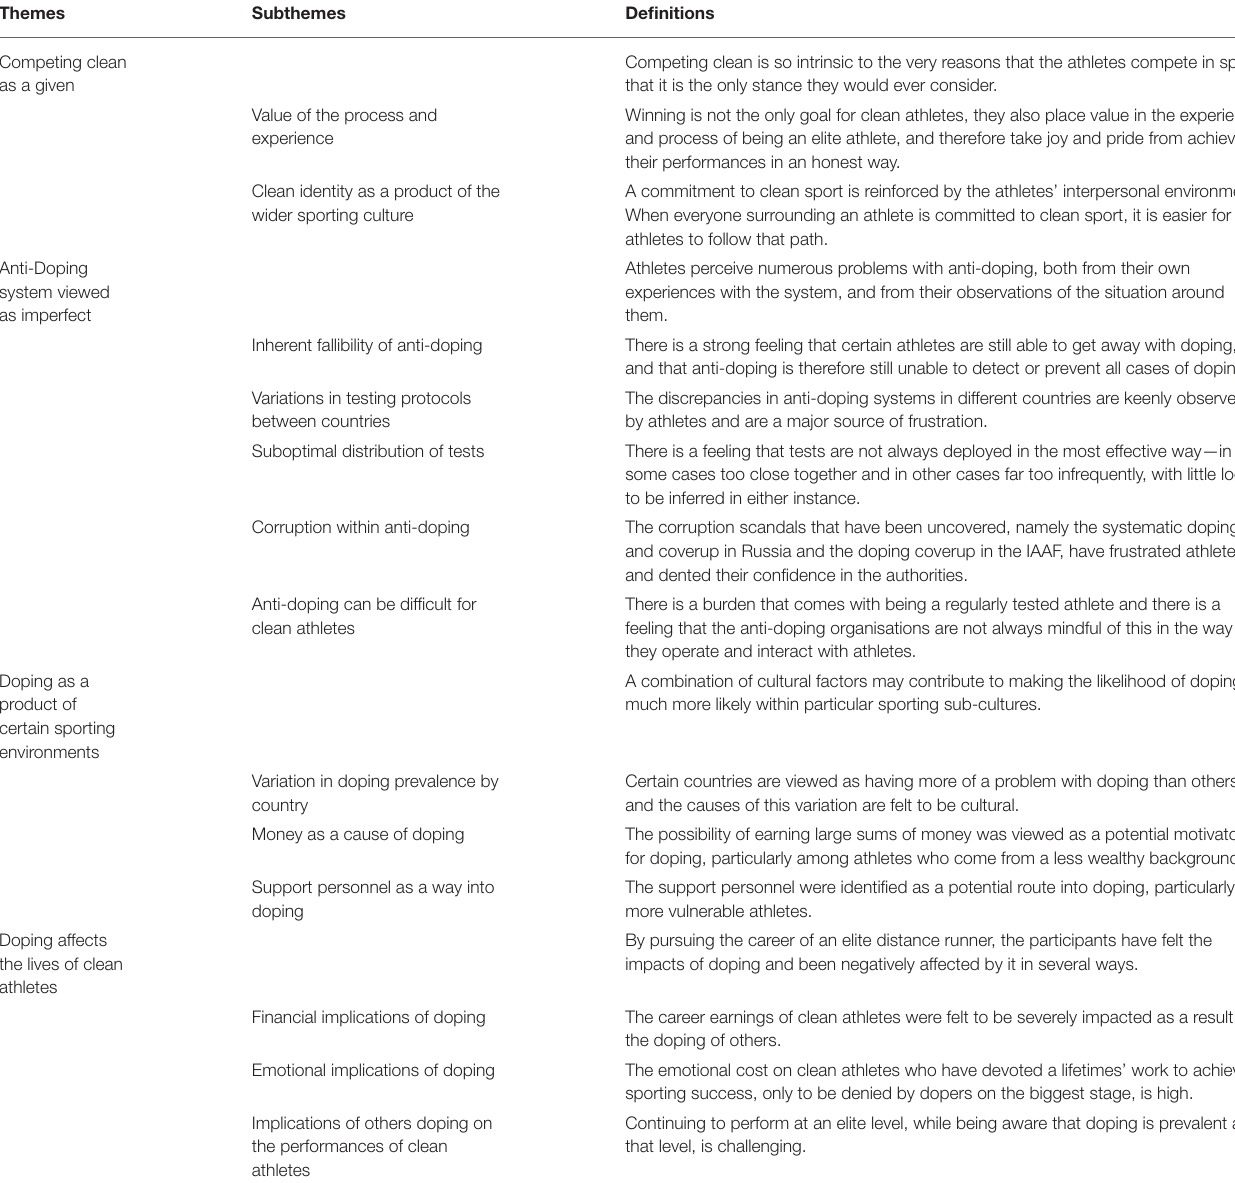
TABLE 1 | Summary of